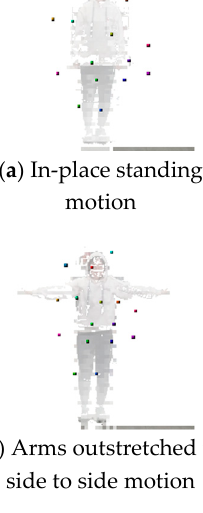
Figure 14. 3D landmarks generated when κ was 16.